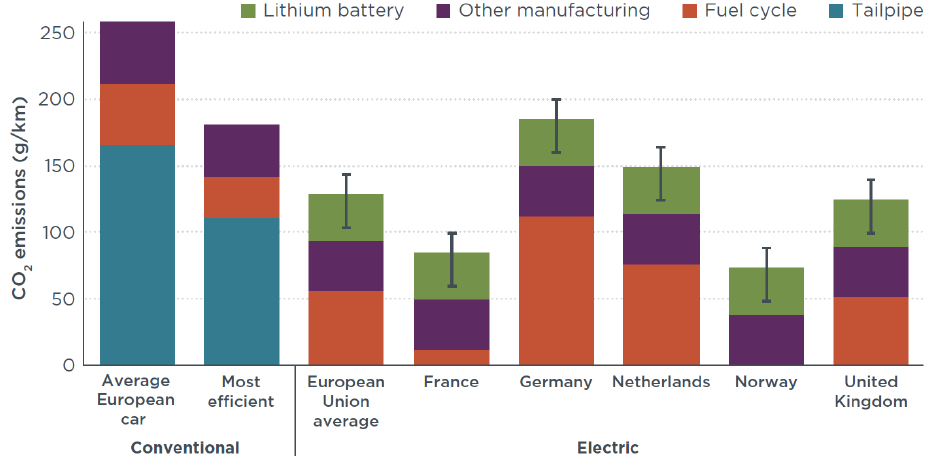
Figure 1. Life-cycle emissions (over 150,000 km) of electric and conventional vehicles in Europe in 2015 [83].